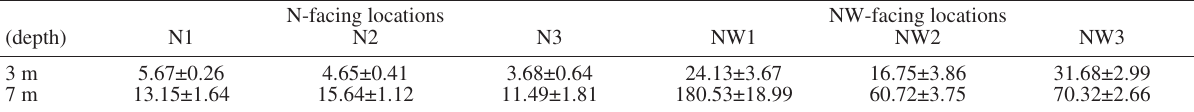
Table 1. – Biomass of G. corneum (mean±se, g dry weight 0.25 m –2 ) in relation to coastal orientation (N, north; NW, northwest), location and